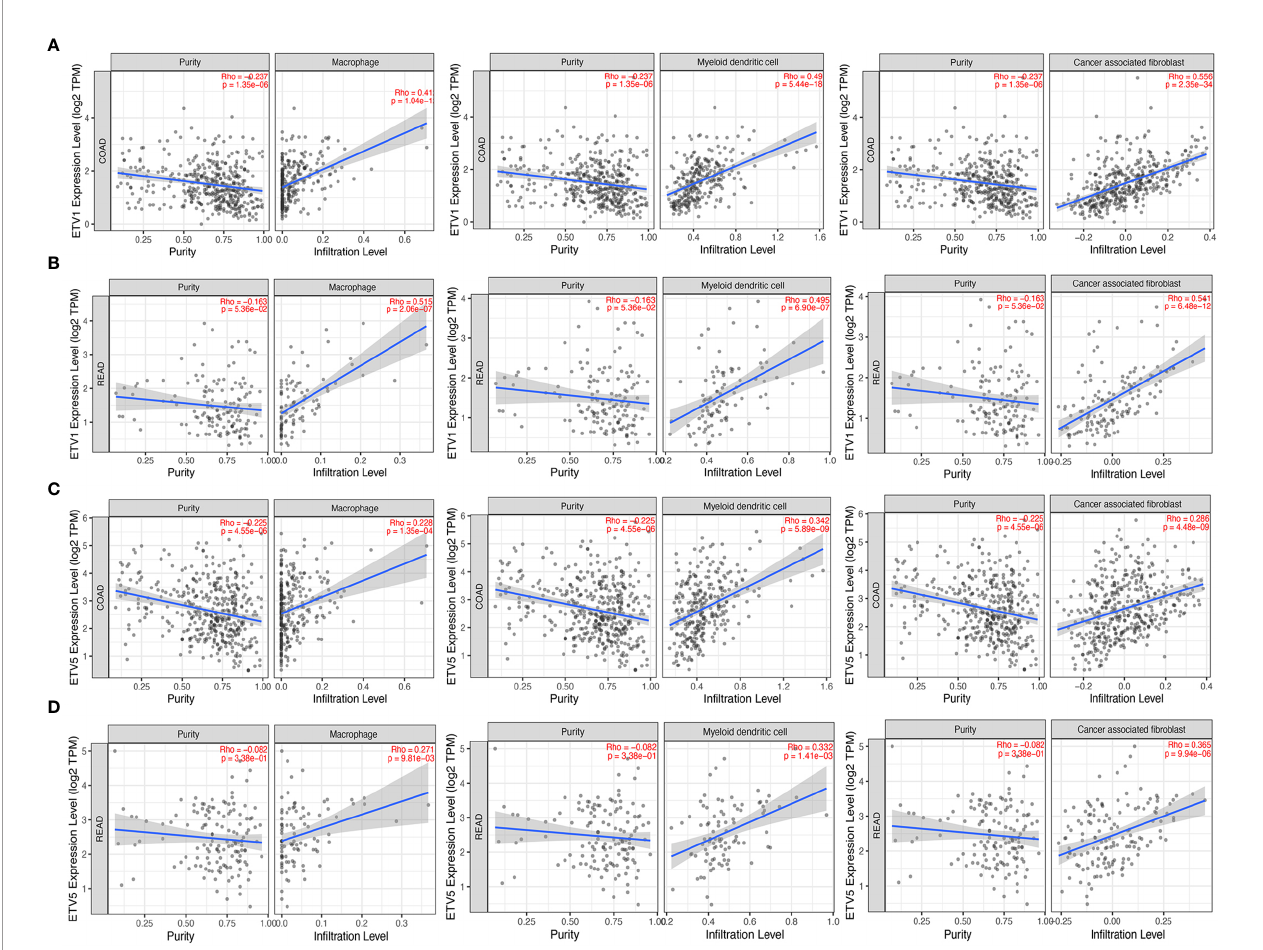
FIGURE 3 | Correlation of ETV1 and ETV5 expression levels with immune cell in fi ltrating levels in colon adenocarcinoma (COAD) and rectal adenocarcinoma (READ). (A) ETV1 expression was negatively related to tumor purity, and ETV1 had positive correlations with in fi ltrating levels of macrophages, dendritic cells, and CAFs in COAD. (B) ETV1 expression was negatively related to tumor purity, and ETV1 had positive correlations with in fi ltrating levels of macrophages, dendritic cells, and CAFs in READ. (C) ETV5 expression was negatively related to tumor purity, and ETV5 had positive correlations with in fi ltrating levels of macrophages, dendritic cells, and CAFs in COAD. (D) ETV5 expression was negatively related to tumor purity, and ETV5 had positive correlations with in fi ltrating levels of macrophages, dendritic cells, and CAFs in